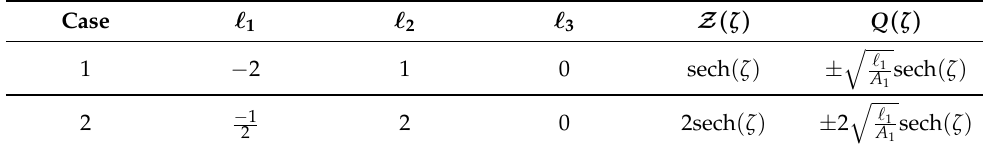
Table 5. All possible solutions for wave Equation (12) when (cid:96) 1 < 0 and m → 1.